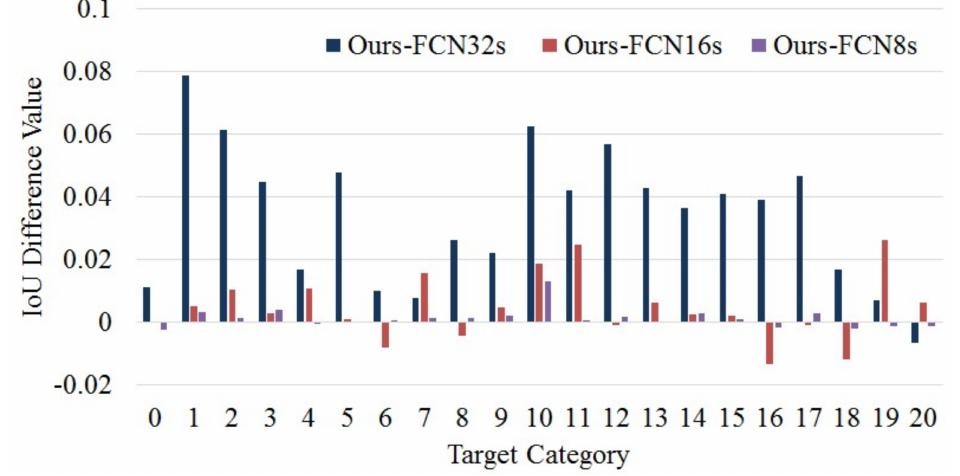
Figure 10. IoU difference value between our algorithm with FCN